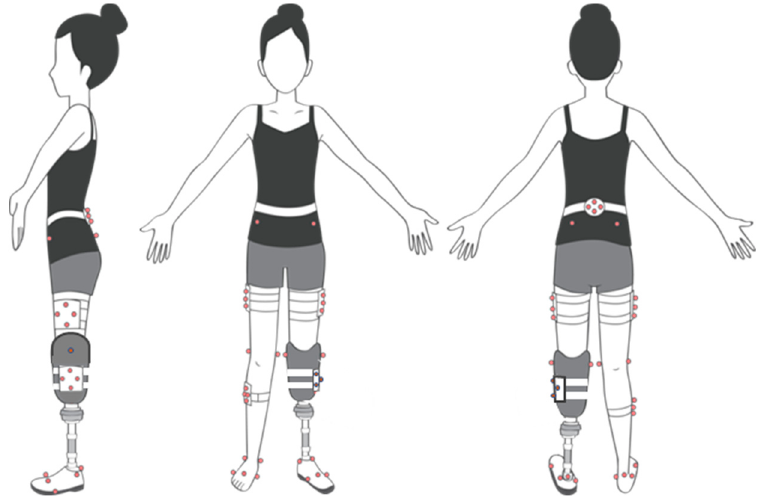
Figure 1. A single comprehensive marker set for two marker models Strathclyde Cluster Model (SCM) and Plug in Gait PiG).